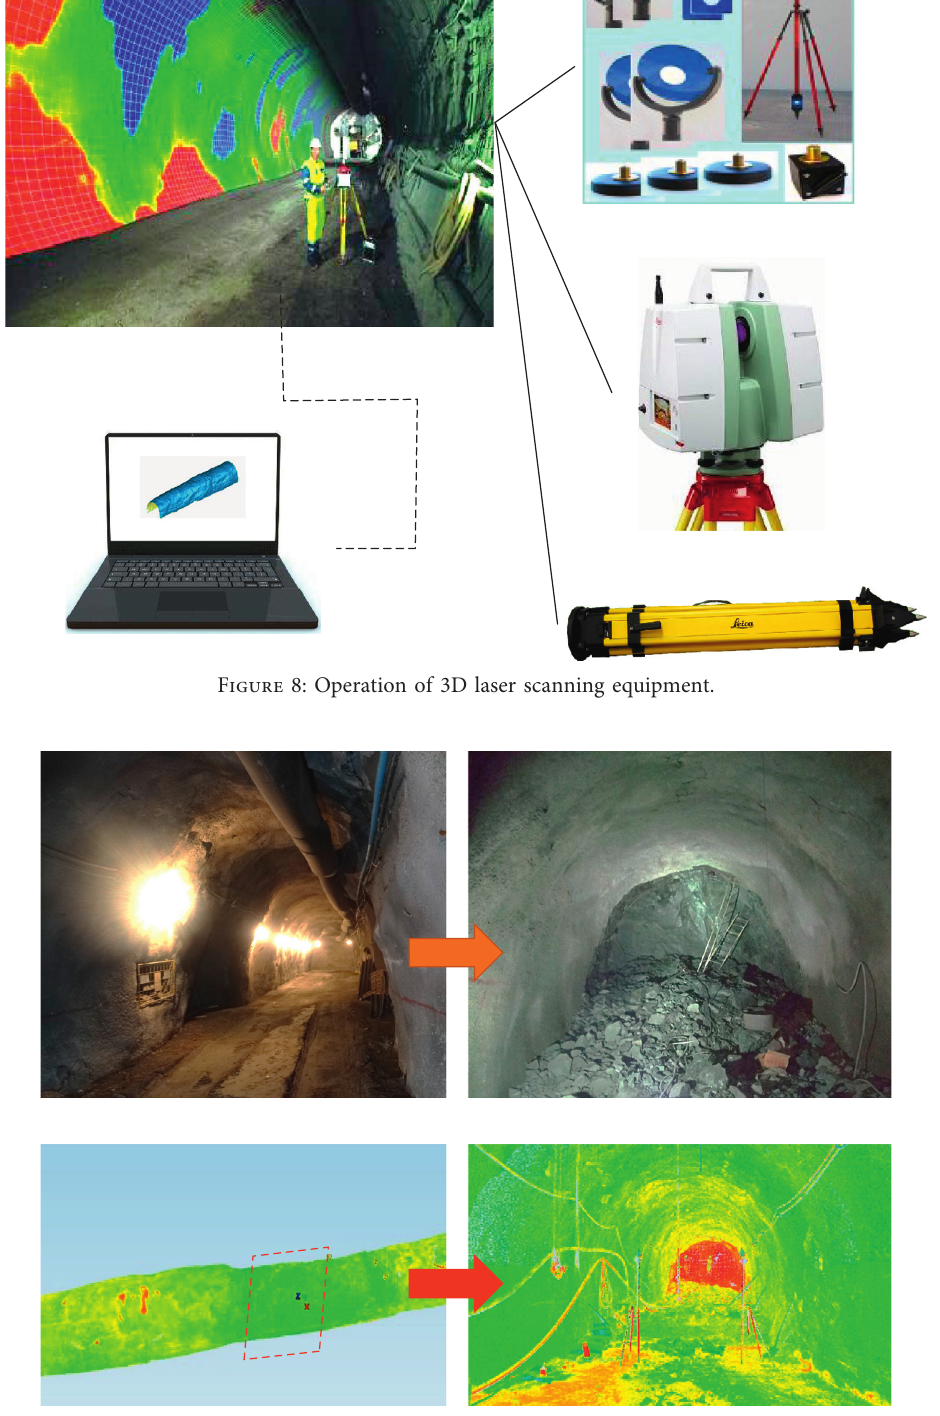
Figure 9: Comparison of the data obtained by real scene photos and 3D laser scanning equipment.